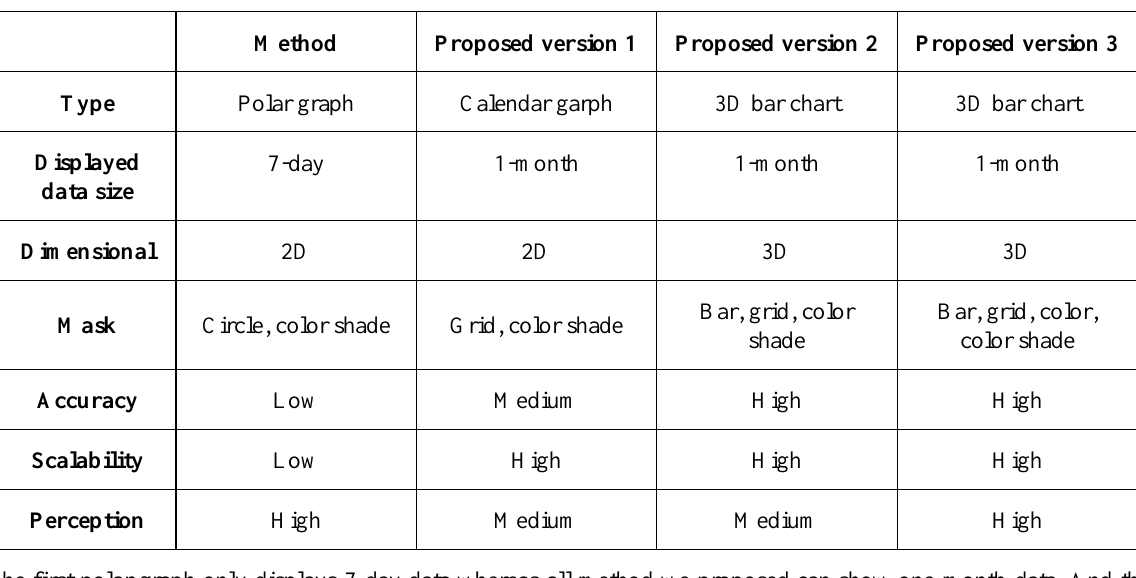
Table 8. Comparation among methods and proposed versions 1, 2 and